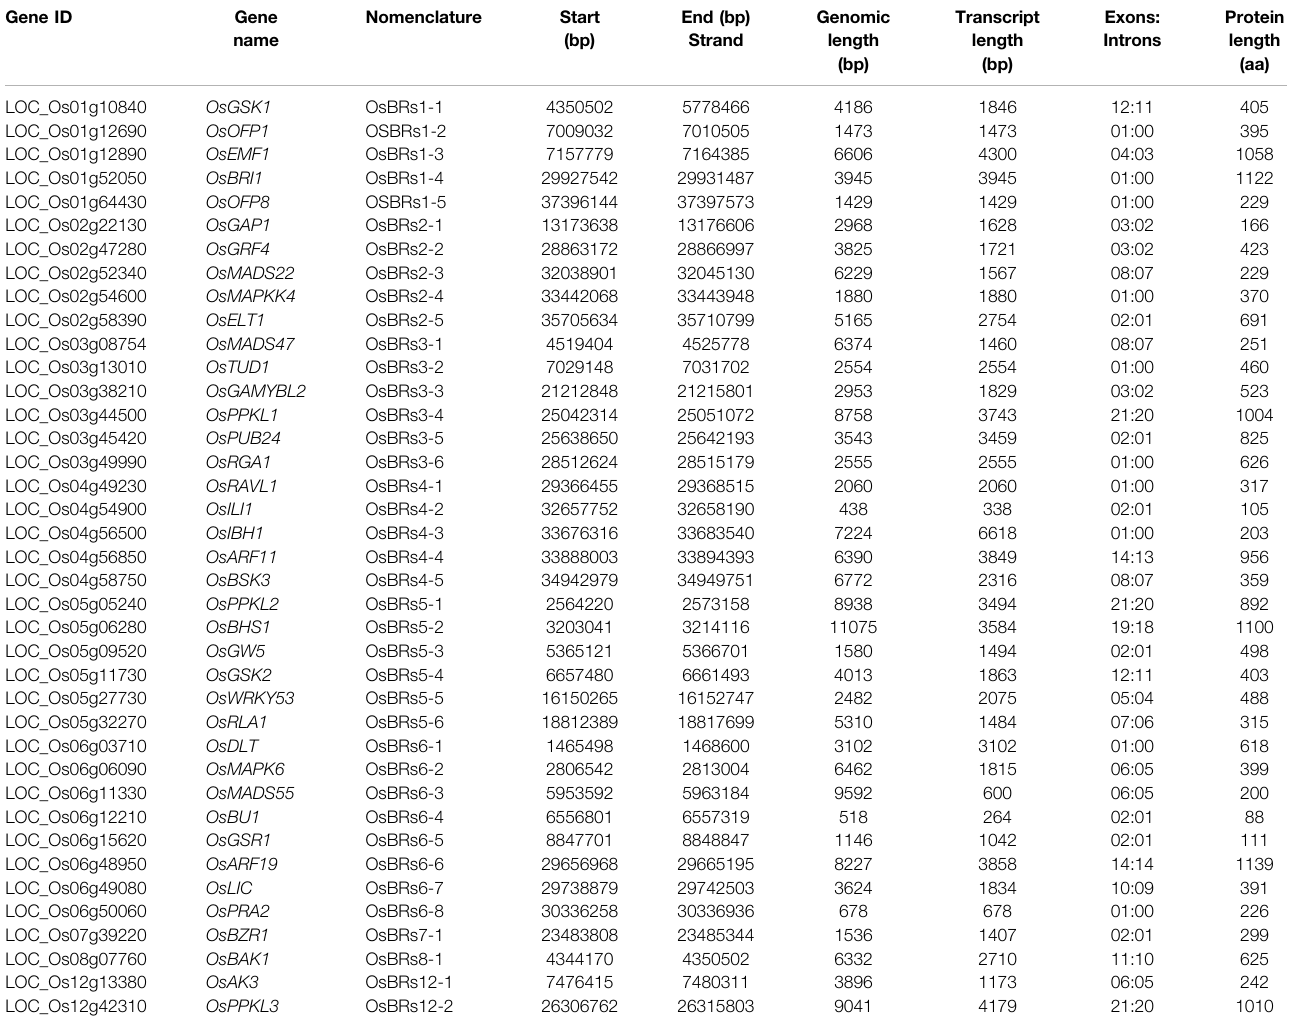
TABLE 1 | Information about the genes involved in the BR signaling in rice and their encoded proteins. Gene